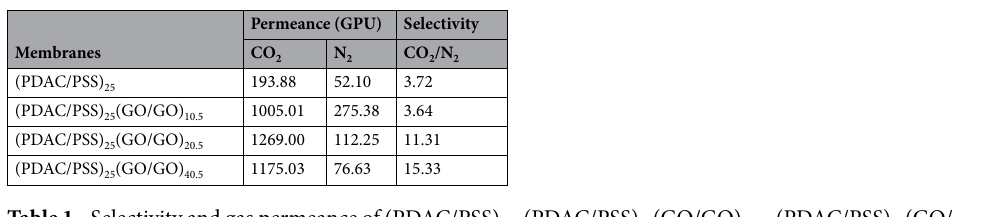
Table 1. Selectivity and gas permeance of (PDAC/PSS) 25 , (PDAC/PSS) 25 (GO/GO) 10.5 , (PDAC/PSS) 25 (GO/